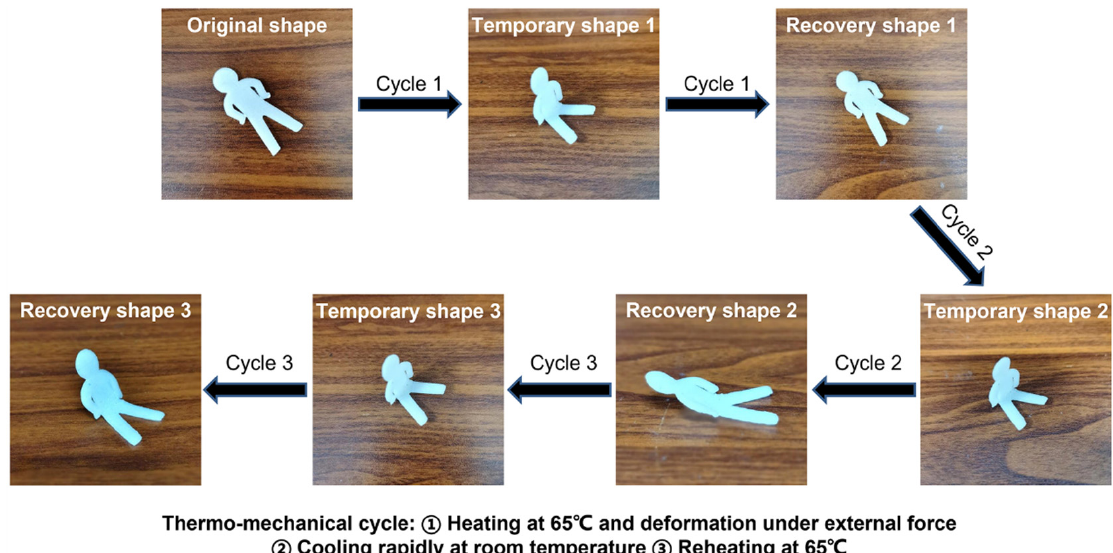
Figure 9. Thermo-responsive cyclic shape memory behavior of a 3D printed doll